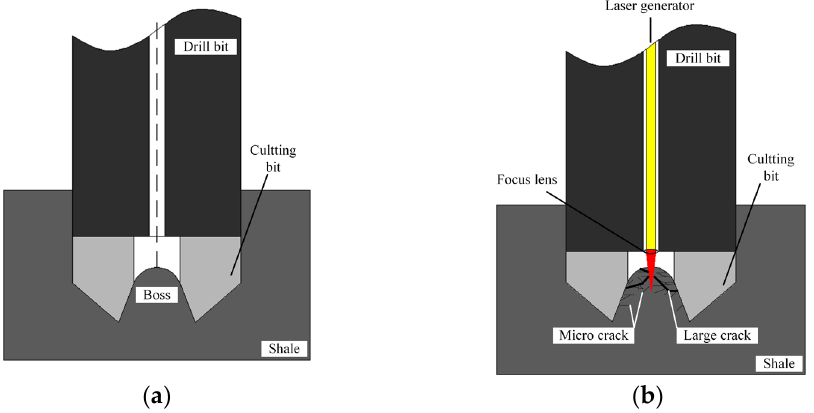
Figure 1. Schematic diagram for ( a ) drilling principle [18], and ( b ) laser-assist principle.